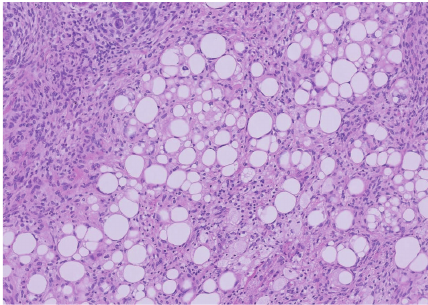
Figure 4: Lipoblastic elements seen admixed with the spindle cell component (H&E × 10 objective).